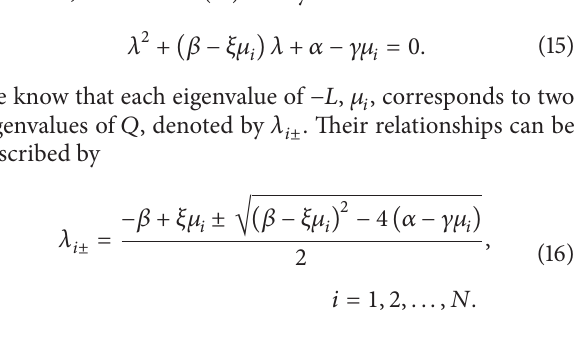
Figure 1: The directed interaction topology of five